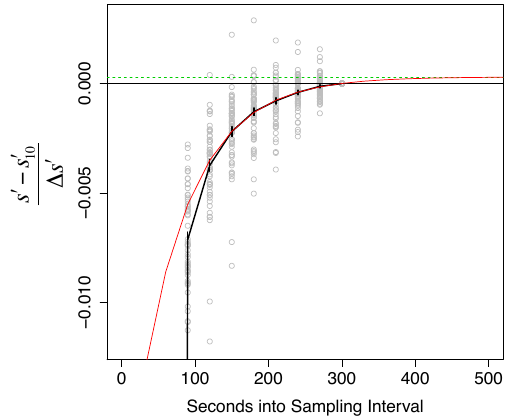
Fig. C1. Approach to equilibration for CO 2 calibration standards for WBI 5–7 August 2009 normalized by the signal difference 1s from the final value for the previous sampling interval. Values rep- resent the signal difference from the INTERVAL = 10 (300s) value per unit difference from previous sampling interval (the analyzer gain is ∼ 1, since the Li-7000 output is estimated χ CO with units 2 ofppm). Gray circles are for individual calibrations, and the heavy solid line corresponds to the mean response computed over all the calibration and target modes. The red curve is a fit to the final three minutes of the mean response given by y = 0 . 00030 − 0 . 020815 × ∼ 100ppm between successive exp ( − ( x − 150 )/ 70 . 55). For 1χ CO 2 sampling modes, the equilibration correction would be + 0.03ppm at INTERVAL =